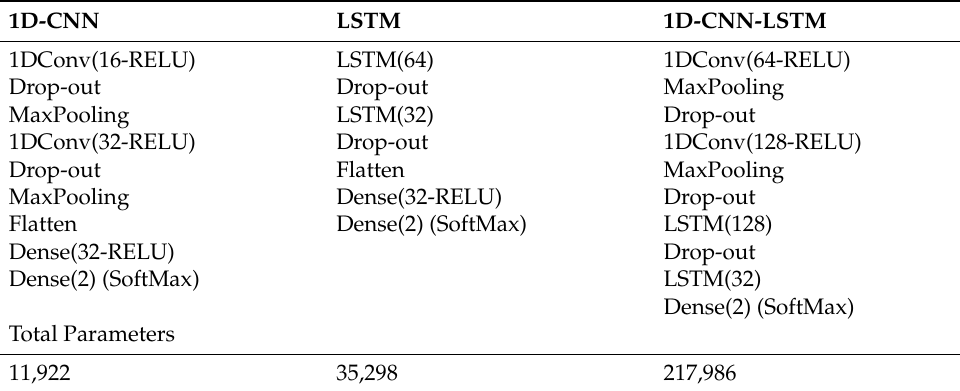
Table 2. The deep learning algorithm designs for time domain.